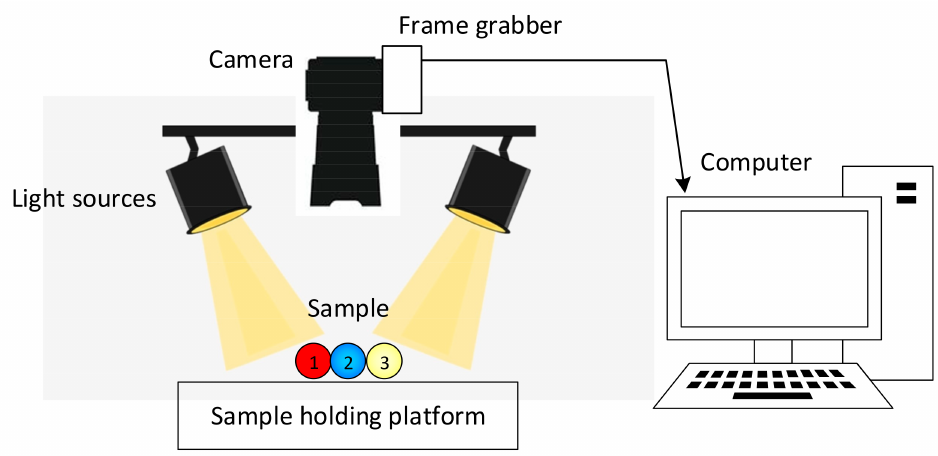
Figure 2. Schematic of a typical colour imaging system adapted from Vithu and Moses